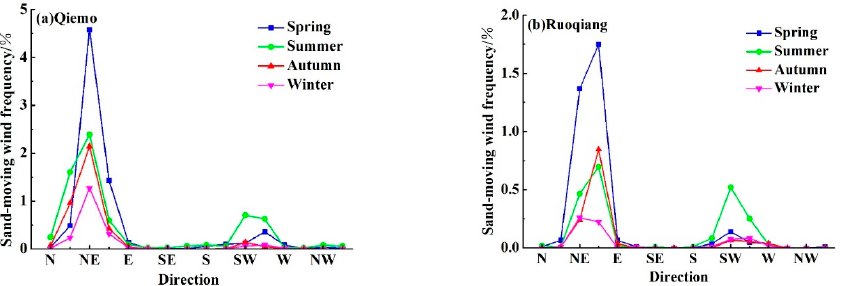
Figure 5. Sand-moving wind frequencies in various directions in the four seasons: ( a ) Qiemo; ( b ) Ruoqiang.